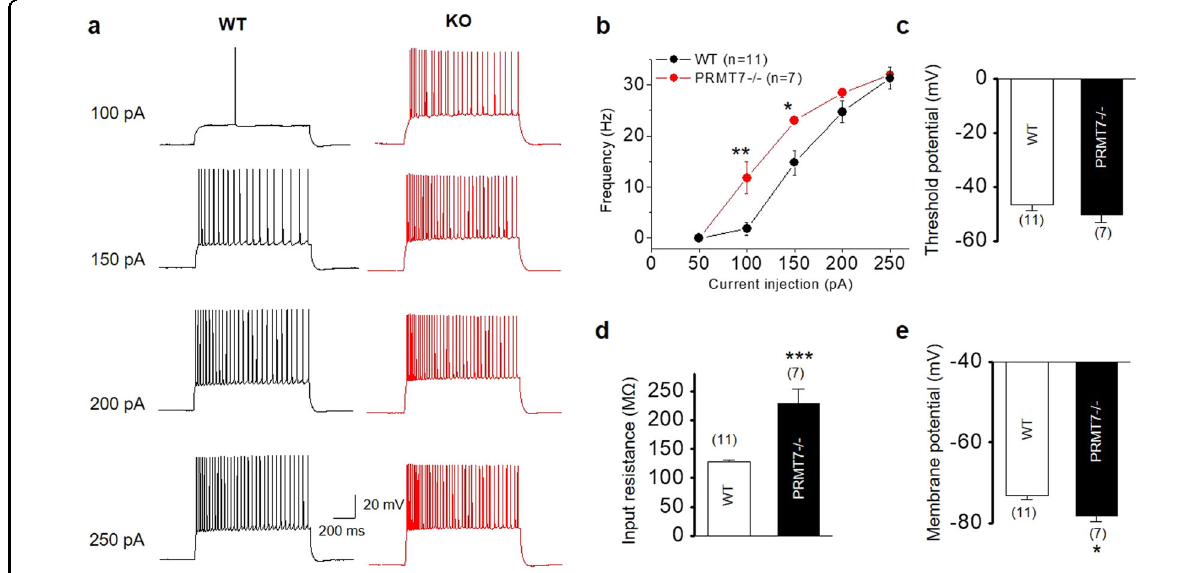
Fig. 2 Increased fi ring frequency in the CA1 pyramidal cells from the PRMT7 KO mice. a Representative traces in the whole-cell current clamp recording in the mature WT and PRMT7 KO CA1 pyramidal cells in response to 1-s depolarizing current injection (from 100 to 250 pA, + 50-pA increment, during 1-s). b The mean number of action potentials (AP no.) plotted against the eliciting currents. At all amplitudes, the mean ± S.E.M. AP no. is signi fi cantly higher in the PRMT7 KO pyramidal cells (red circles; n = 7) than in the WT pyramidal cells (black circles; n = 11). c – e The mean value of the threshold potential ( c ), the input resistance ( d ), and the resting membrane potential ( e ) in the WT and PRMT7 KO CA1 pyramidal cells. * p < 0.05; ** p < 0.01; *** p < 0.001; Student ’ s t